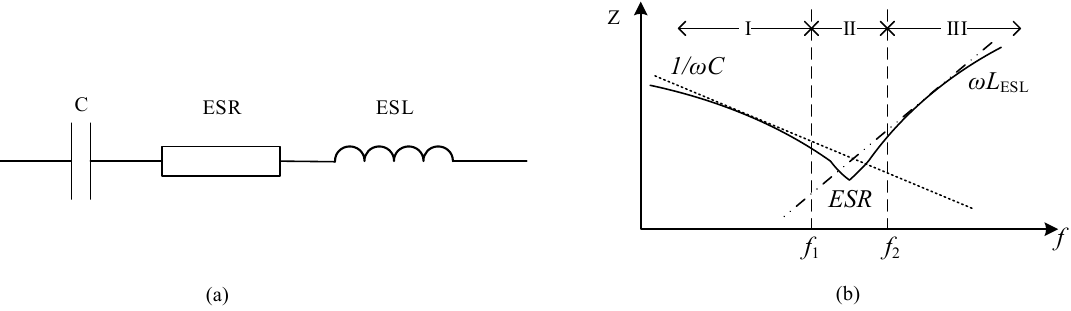
Figure 5. Equivalent circuit and dominant impedance of a capacitor: ( a ) equivalent circuit of capacitor; ( b ) dominant impedances in different regions of the capacitor.